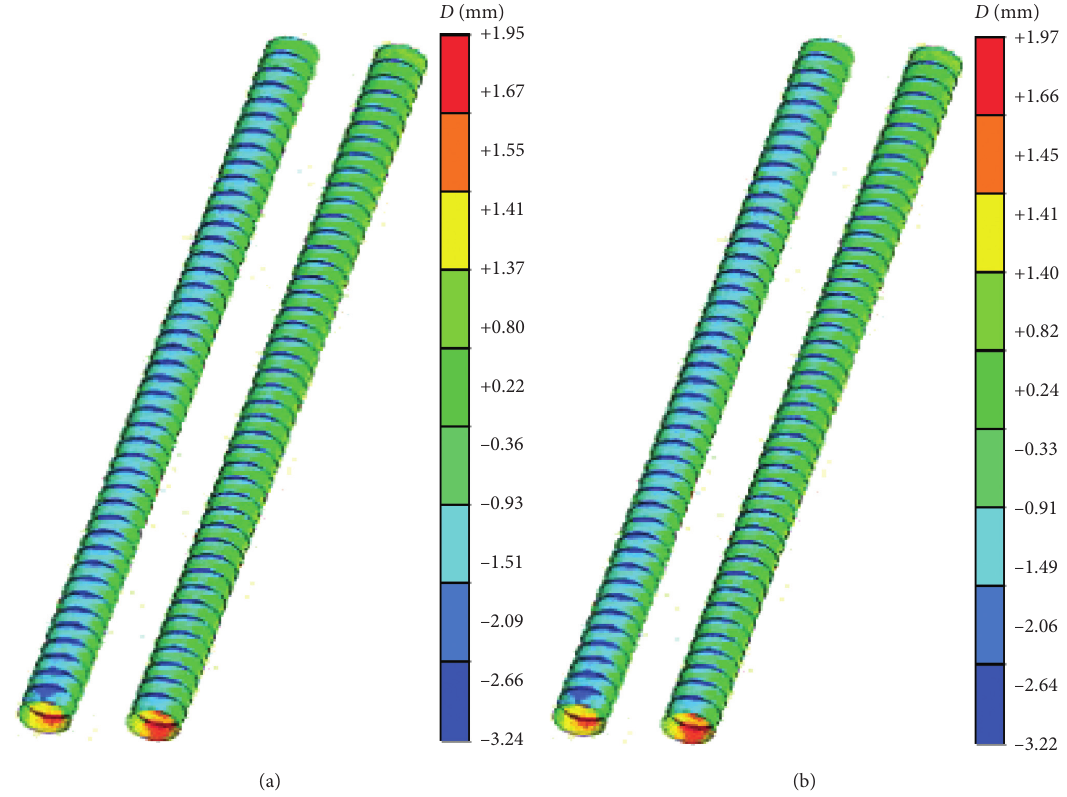
Figure 13: Cloud diagram of the vertical settlement of the newly built tunnel segment. (a) Excavation program I. (b) Excavation program